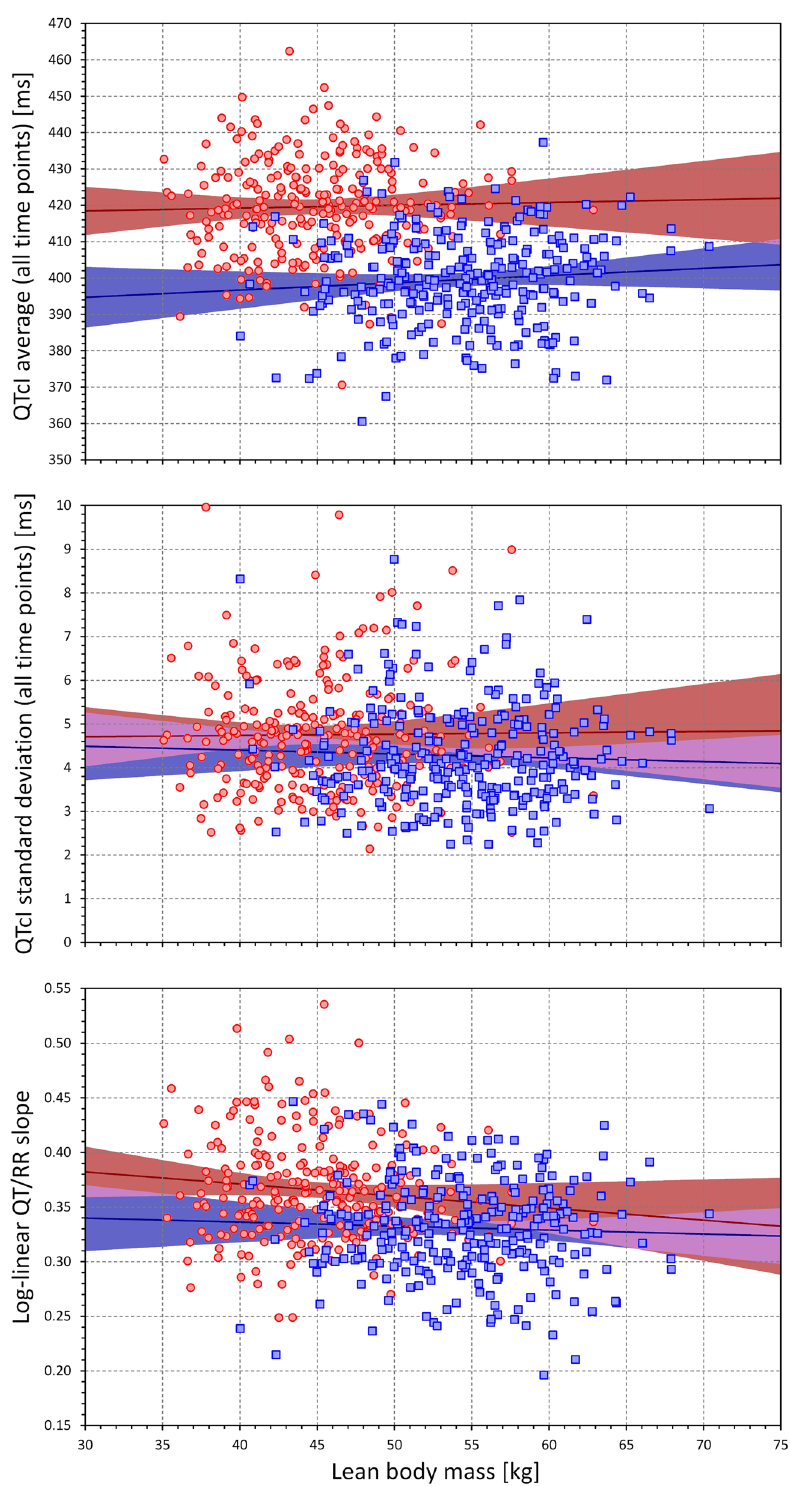
Figure 5. Scatter diagrams between the lean body mass and mean QTcI values of all ECG measurements in all study time-points (top panel), standard deviation of QTcI values of all ECG measurements in all study time- points (middle panel), and subject-specific log-linear QT/RR slope (bottom panel). The meaning of symbols and Figure layout is the same as in Fig. 3. kg kilograms, ms